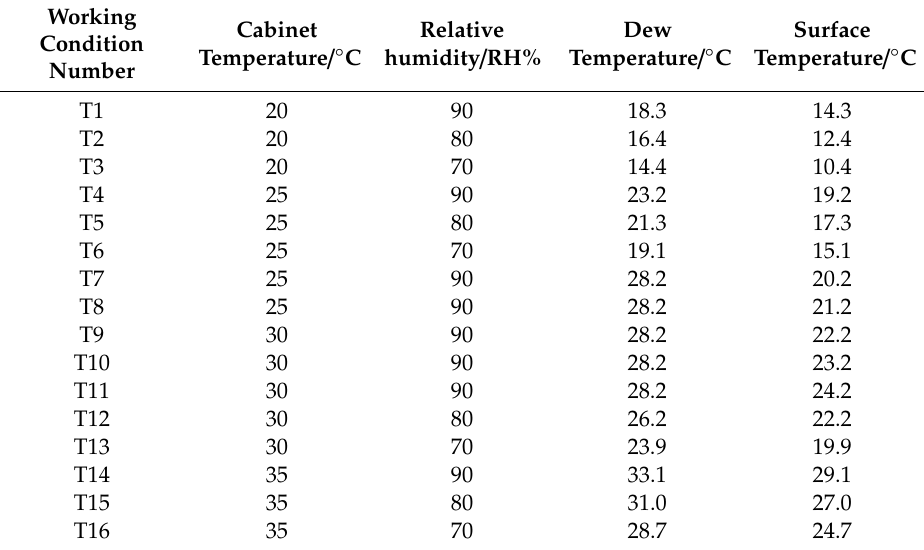
Table 2. Condensation simulation test conditions setting.